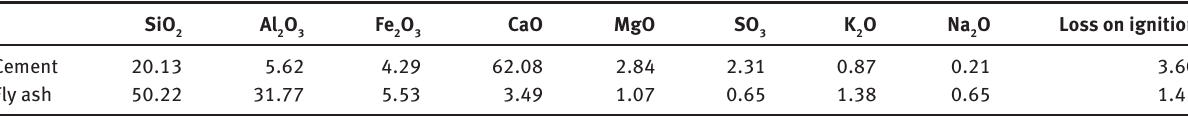
Table 1: Cement and fly ash chemical compositions (mass%).